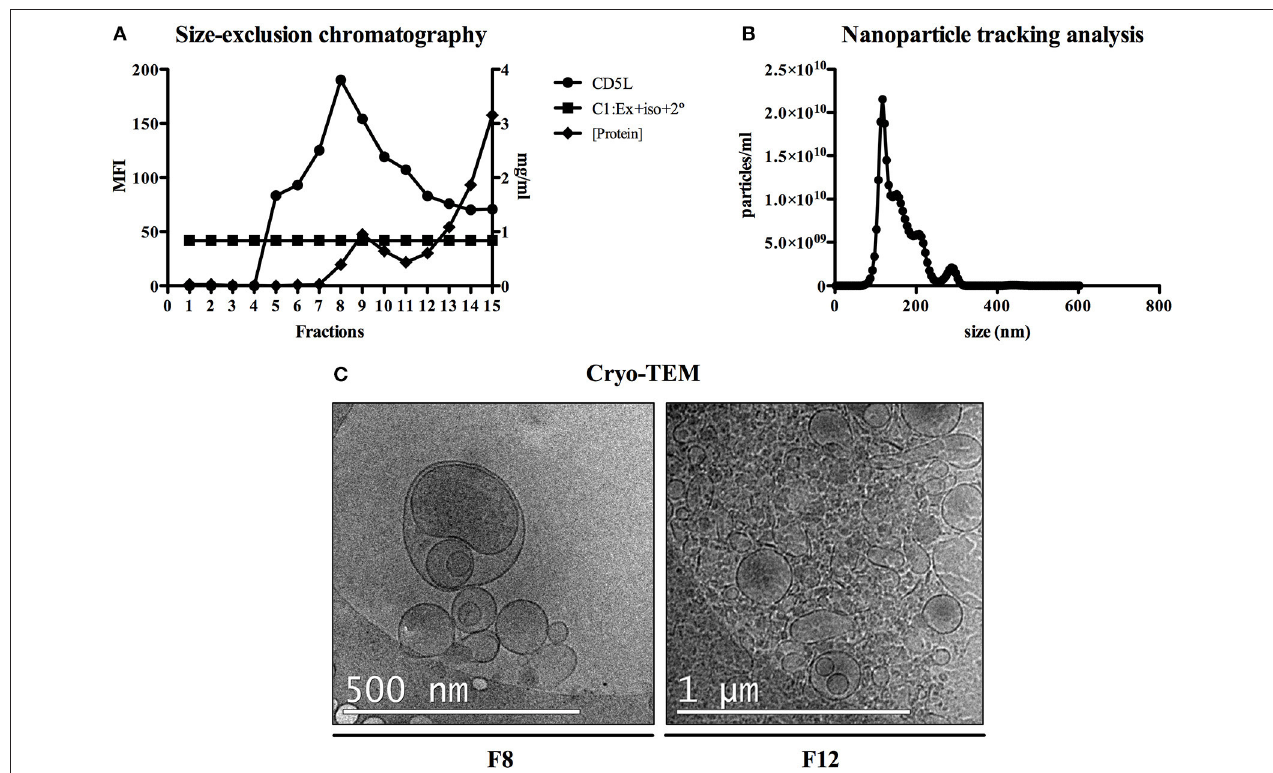
FIGURE 1 | Exosomes purification and characterization. (A) SEC fractions of plasma-derived exosomes from P. vivax infected FRG huHep mice from EI1 and EI2 were analyzed in a flow cytometry bead-based assay for the presence of exosomal marker CD5L. Mean fluorescence intensity (MFI) of anti-CD5L and control antibodies (rabbit-isotype) as well as protein concentration was assayed for each fraction and a representative analysis for a single sample is shown. (B) NTA profile (size [nm] vs. concentration [particles/ml]) of the fraction with the highest CD5L MFI (F8) shows enrichment in nanoparticles around 120nm. (C) Cryo-EM of F8 confirms the presence of abundant, round nanovesicles measuring 100–150nm. SEC fraction 12 (F12) identified aggregates and nanovesicles of diverse